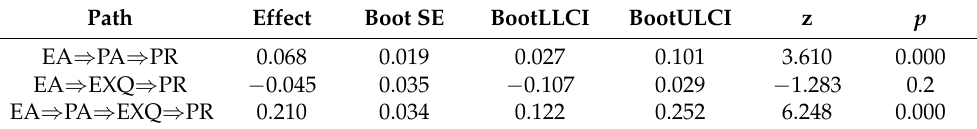
Table 12. Results of indirect effects